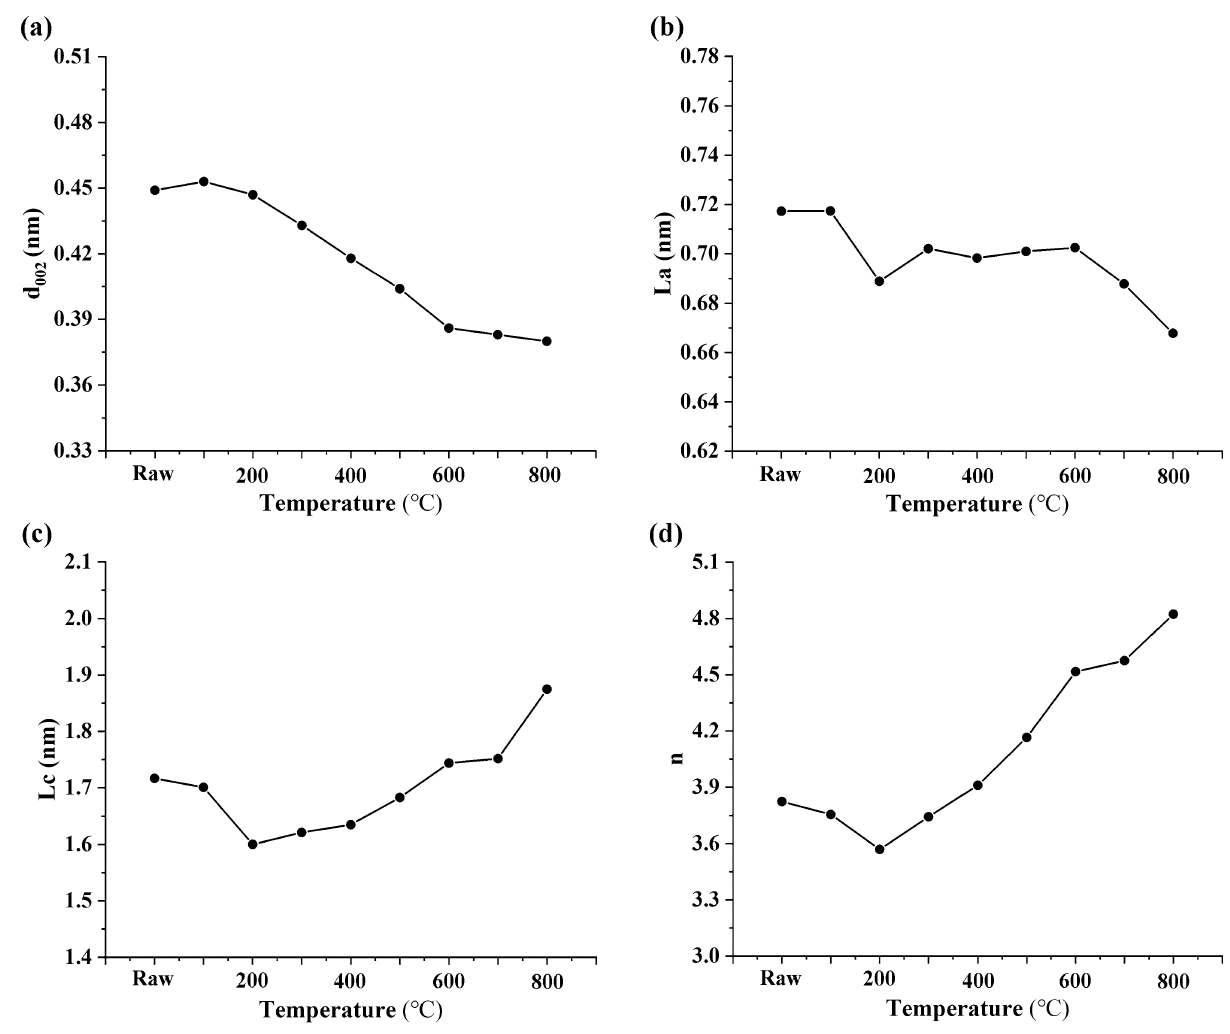
Figure 6. Changes in the stack structural parameters with heat treatment. ( a : d 002 , b : La, c : Lc, d :